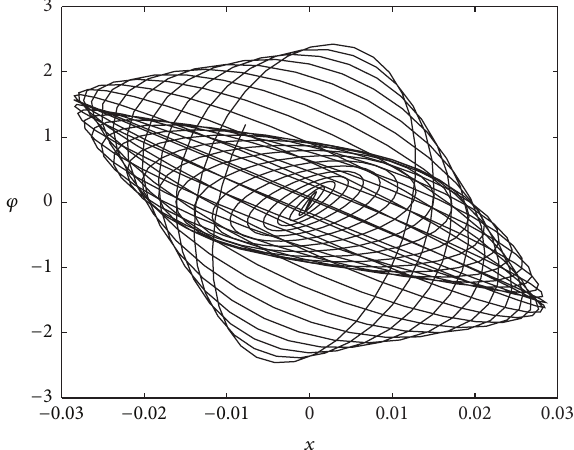
Figure 11: Diagram displaying the portrait of 𝑥 against 𝜑 when 𝜔 2 = 0.2